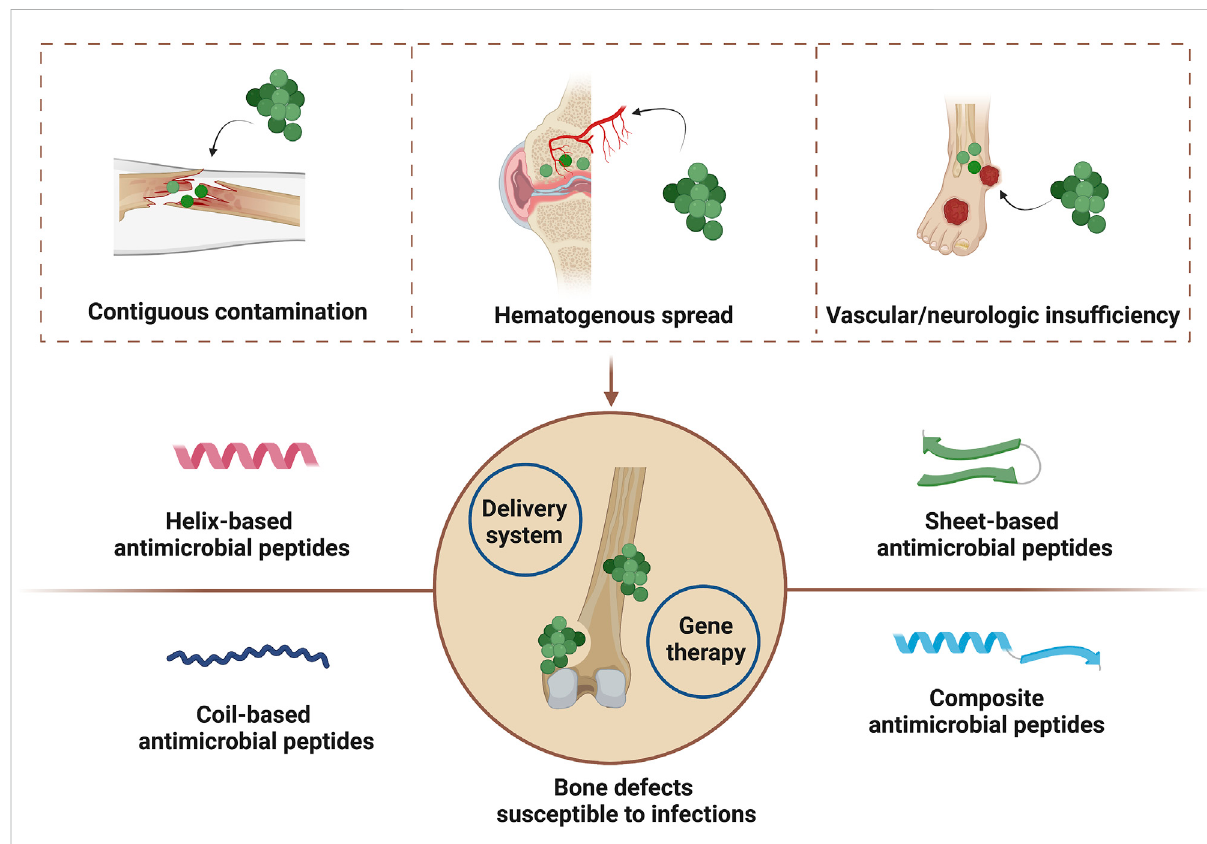
FIGURE 1 Mechanisms of bone infections and antimicrobial peptide-based strategies for the healing of bone defects susceptible to infections. Created with